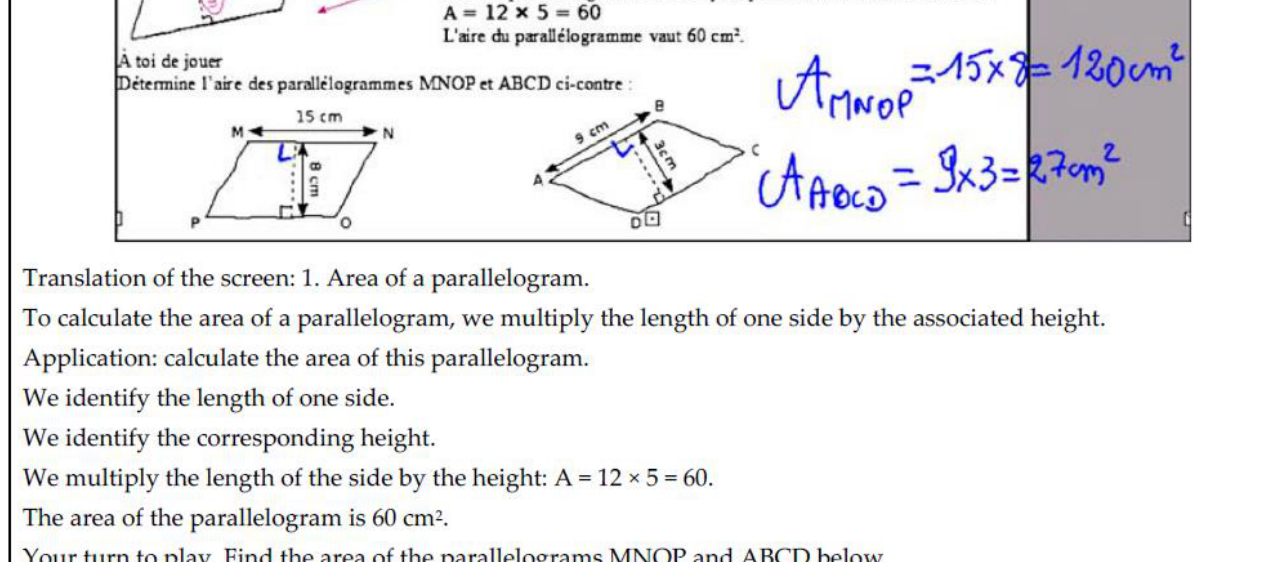
Figure 3. Traces, on an interactive whiteboard, of a teacher’s work introducing the computation of the area of a parallelogram ([68], p. 208).